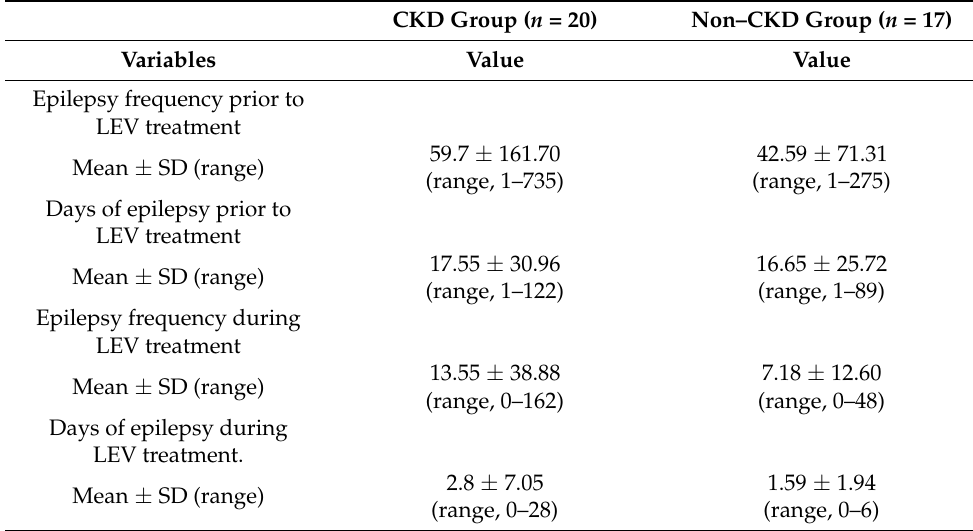
Table 3. Seizure frequency of the CKD group/non–CKD group.